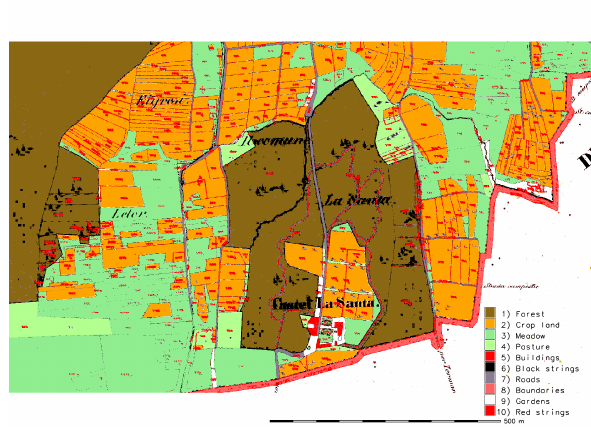
Figure 4. Classified map for contextual supervised MLC -